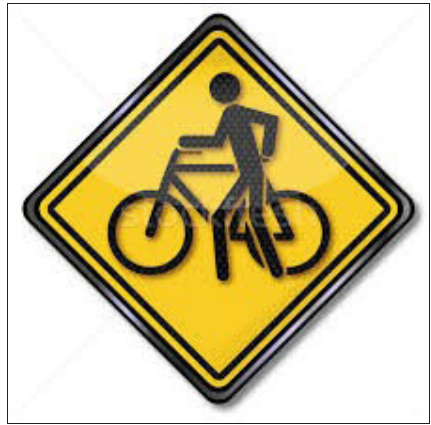
Figure 1: Cyclists dismount. Image from stockfresh images / cyclists